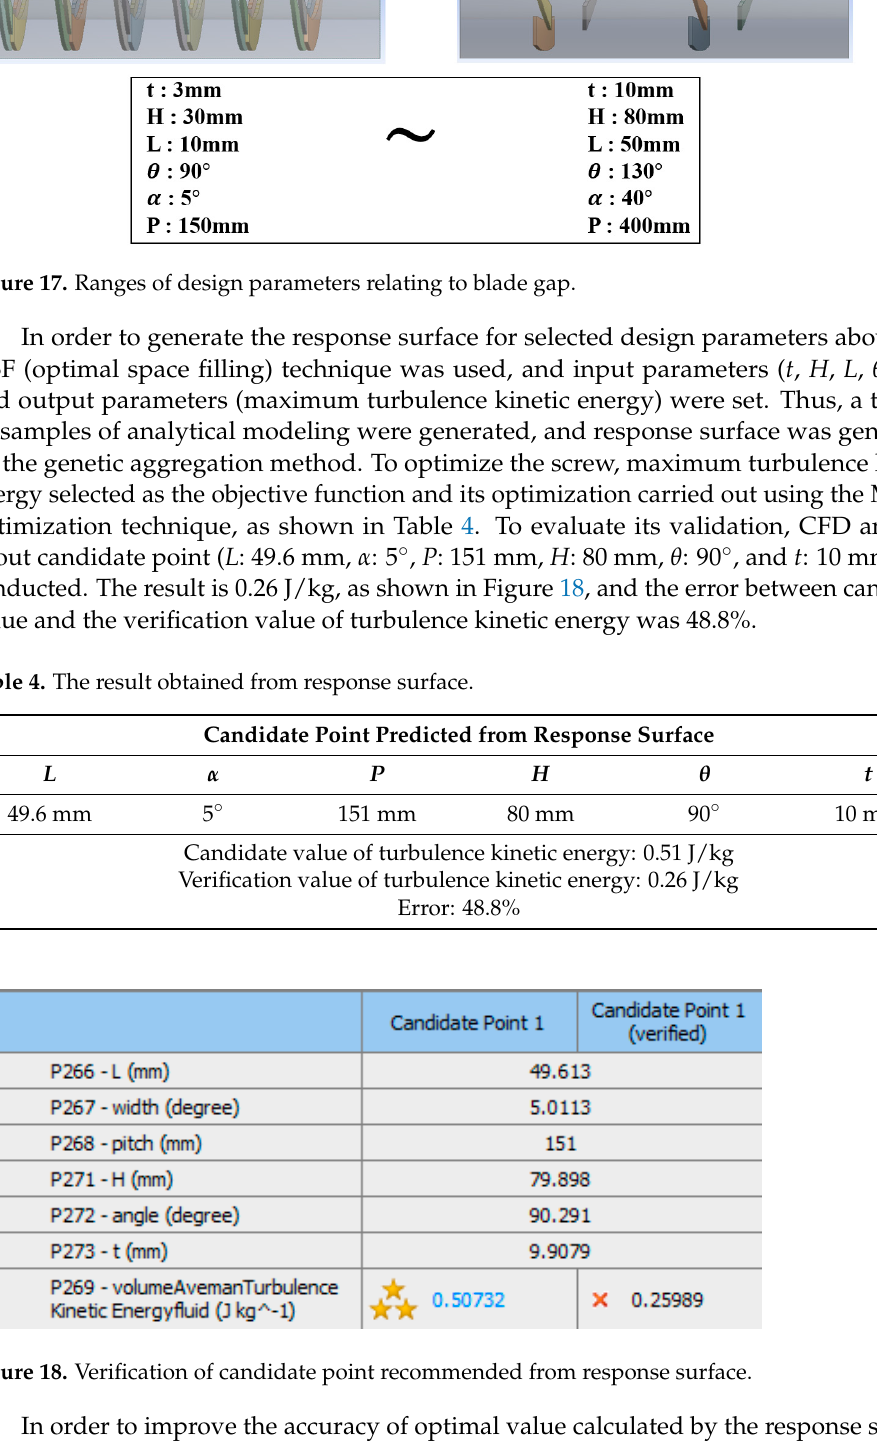
Figure 16. Design parameters relating to blade gap.